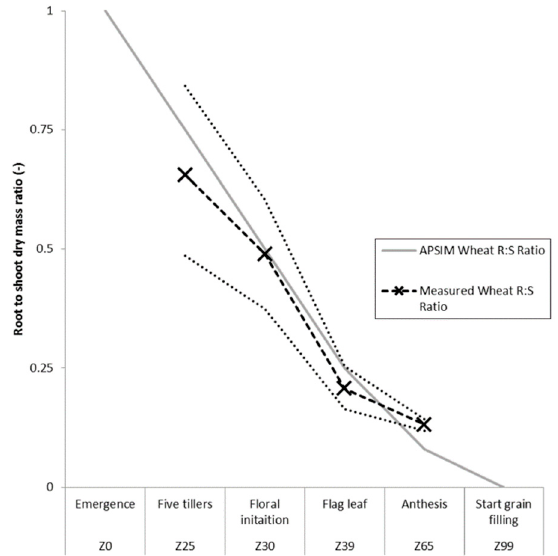
Figure 4. Dynamic of the root to shoot ratio (R:S) of wheat obtained with minirhizotron. The average root to shoot ratio ( × ) is presented with the confidence interval at 95% level (dashed lines). The solid grey line is the R:S ratio used for modelling wheat growth in the APSIM model. Root biomass results from the summation of the two different root sampling techniques, i.e. auger and minirhizotron sampling. Data are obtained for tillering (Z25), stem elongation (Z30), flag leaf ligule (Z39) and anthesis half-way (Z65).